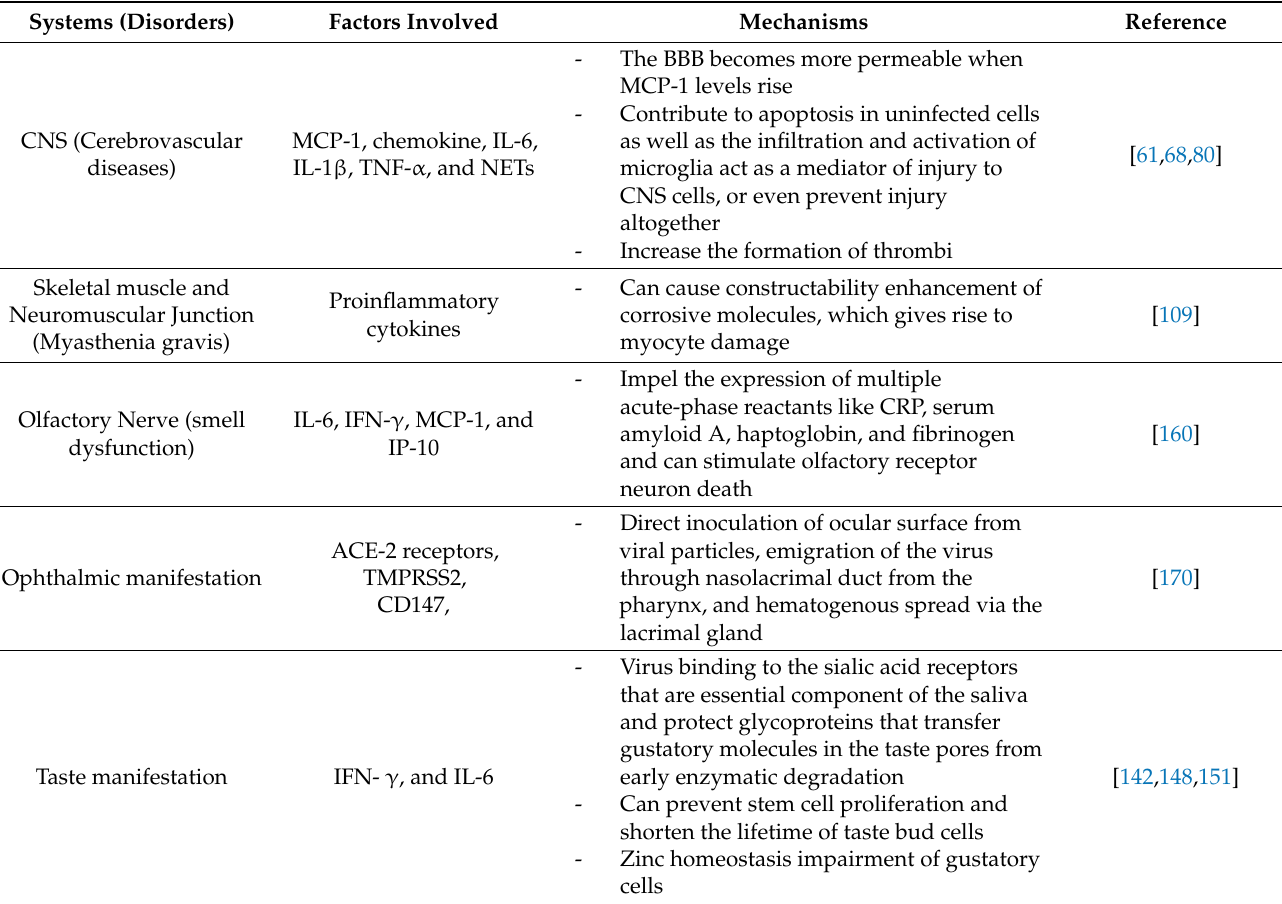
Table 1. Description of different mechanisms involved in COVID-19